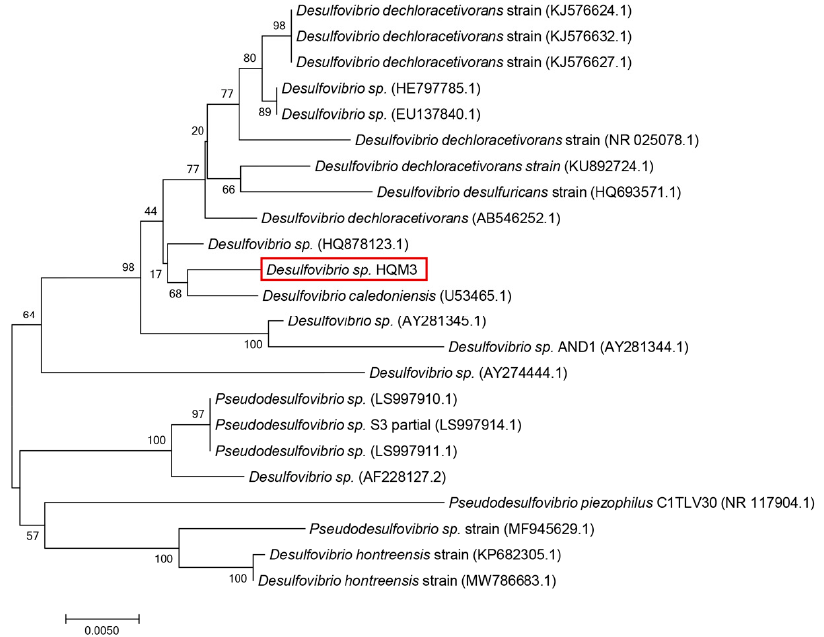
Figure 2. Phylogenetic position of Desulfovibrio sp. Figure 2 . Phylogenetic position of Desulfovibrio sp. HQM3.